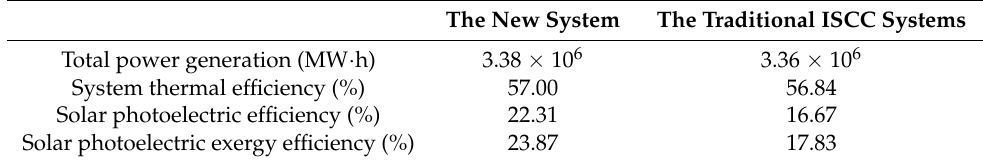
Table 8. Annual thermal performance data. The New